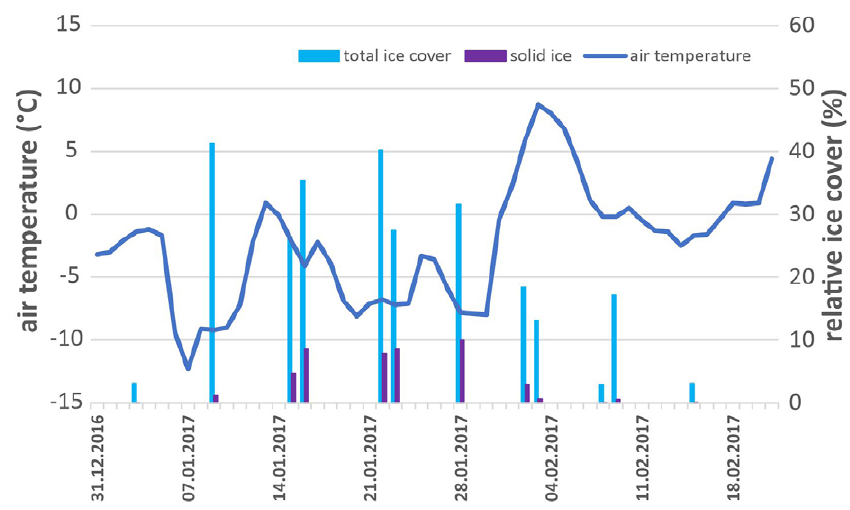
Figure 11. Daily mean air temperature between the period of 1st of January and 20th of February 2017, and the change of summed relative ice cover on the Dunaföldvár-Beograd section of the Danube